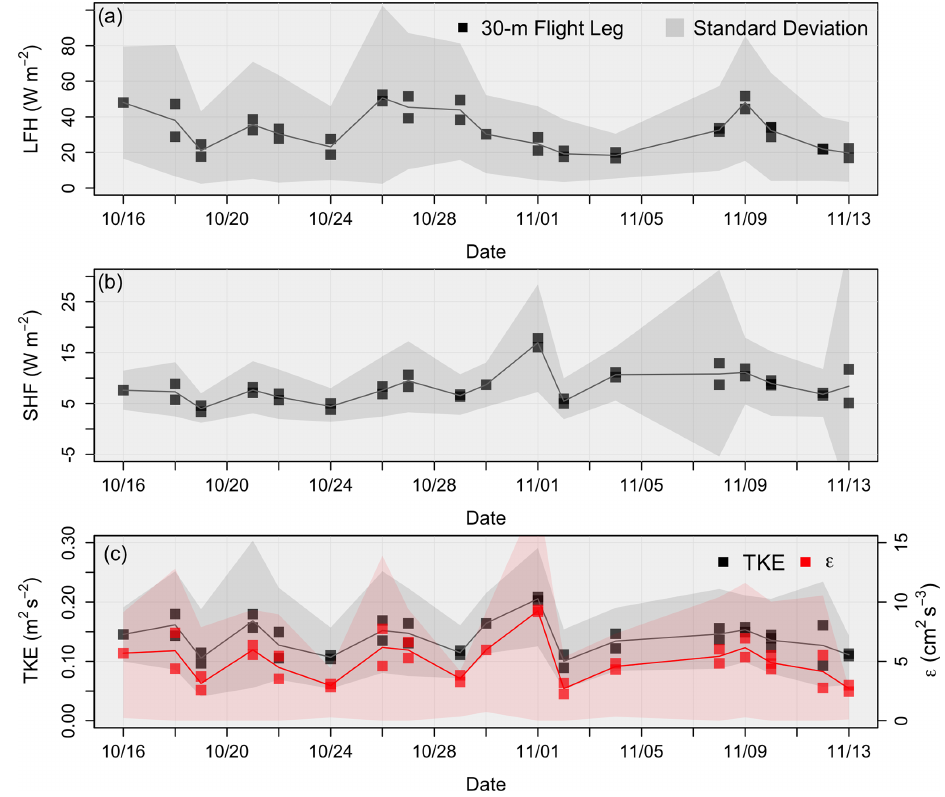
Figure 7. Values of (a) surface LHF (Wm − 2 ), (b) surface SHF (Wm − 2 ), and (c) surface TKE (m 2 s − 1 ) in black and surface (cid:15) (cm 2 s − 3 ) in red for each flight day. Each square is a mean of a 30m horizontal flight leg, while each envelope represents the standard deviation. Table 3. Mean and range of values for select surface variables over the 18 flights analyzed, with the standard deviation and the research flight number in parentheses for column mean and range,